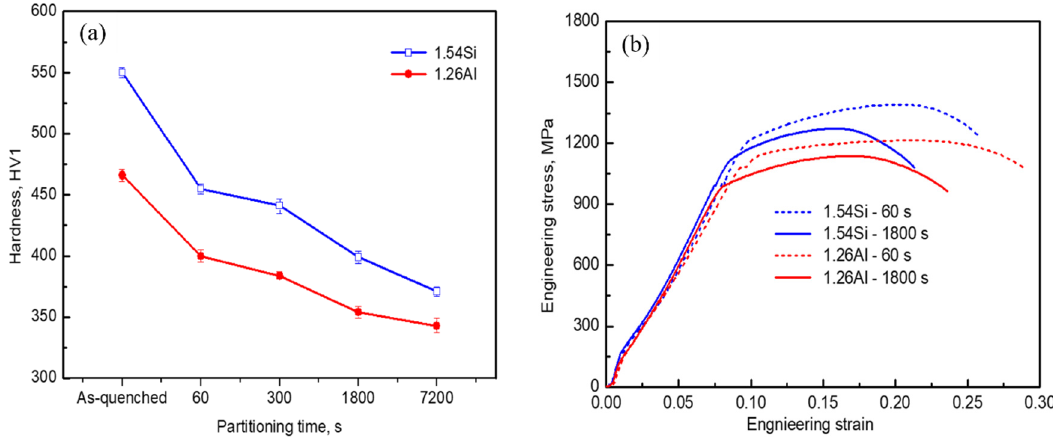
Figure 7. Mechanical properties of the samples: ( a ) hardness; ( b ) engineering stress–strain curves. Table 1. Tensile properties of the investigated steel.